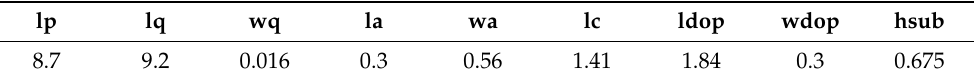
Figure 1. The polarization reconfigurable antenna. ( a ) Top view. ( b ) Side view. Table 1. Dimensions (in mm) of the two linear polarization reconfigurable antenna.